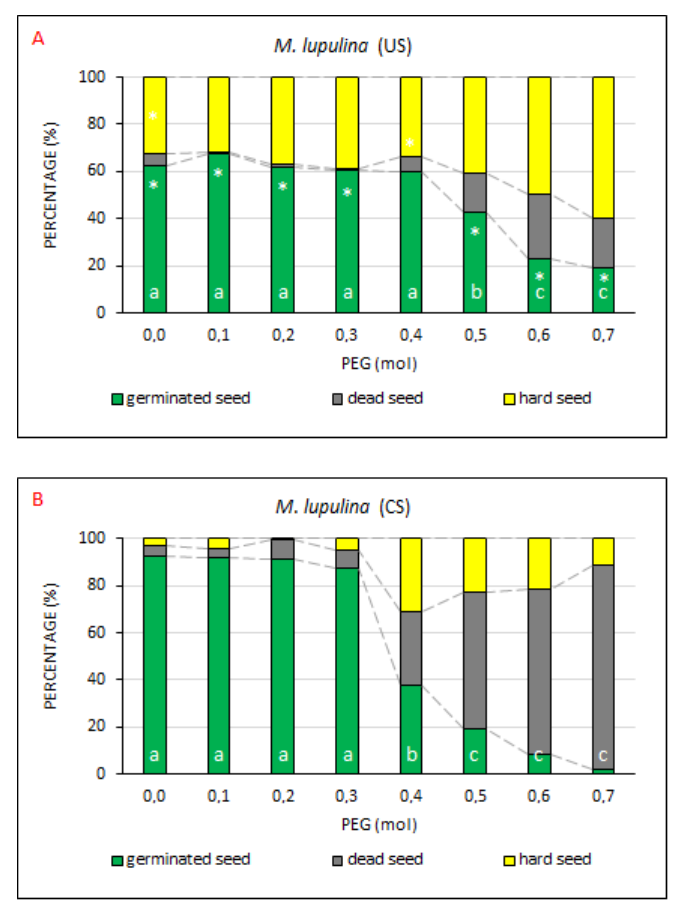
Figure 7. The comparison of germinated, dead and hard seed percentages at drought resistance degrees. Average percentages of GS, DS and HS for M. lupulina , the ( A ) US (uncoated seeds; n = 4 ± SE) and ( B ) CS (coated seeds; n = 4 ± SE) treatments at the respective PEG concentrations = 0.0–0.7 mol. Different lowercase letters indicate a significant difference (ANOVA post-hoc Tukey’s HSD test; p < 0.05) between the percentage of GS values in the US and CS treatments. The * symbol represents a significant difference in the percentages of GS values between US and CS at a specific PEG concentration.